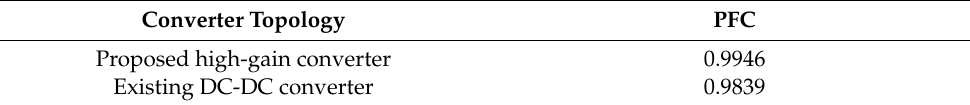
Figure 12. Power factor correction. Table 5. Comparison table of the converter topology with PFC.